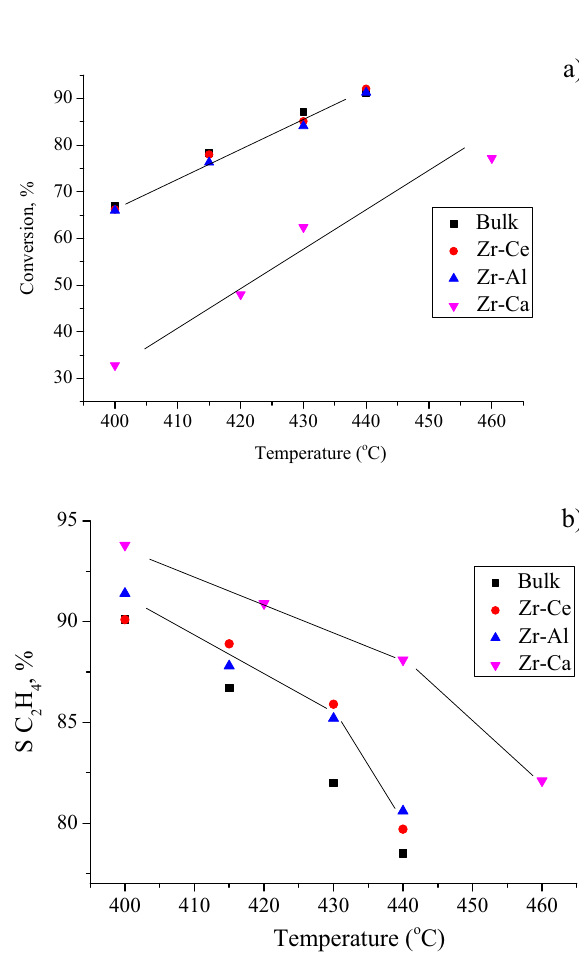
Figure 9: Comparison of C 2 H 6 conversion ( a ) and ethylene selectivity ( b ) dependence on temperature at contact time 5.52 s for bulk MoVTeNbO oxide and its composites with 10 wt% of Zr – Ce - , Zr – Al - , and Zr – Ca - PilCs.